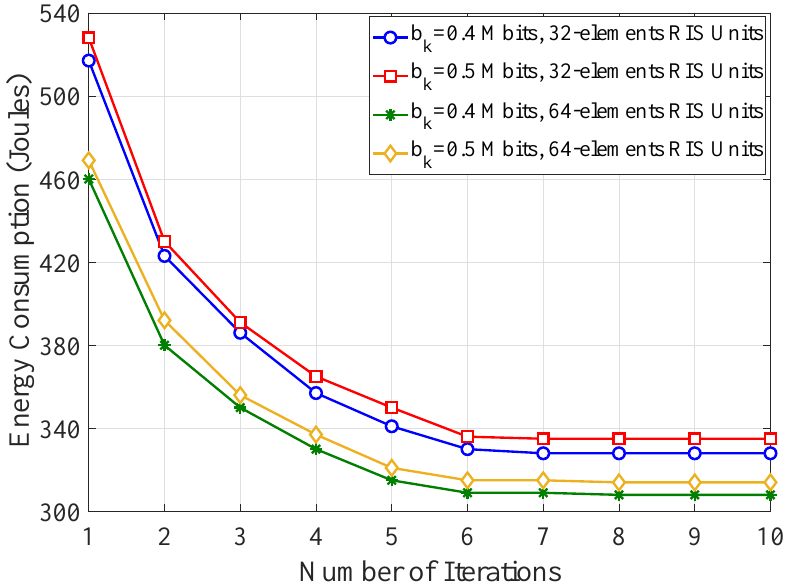
Figure 10. The optimized WTEC as a function of the number of iterations for varying task requirement and number of reflecting